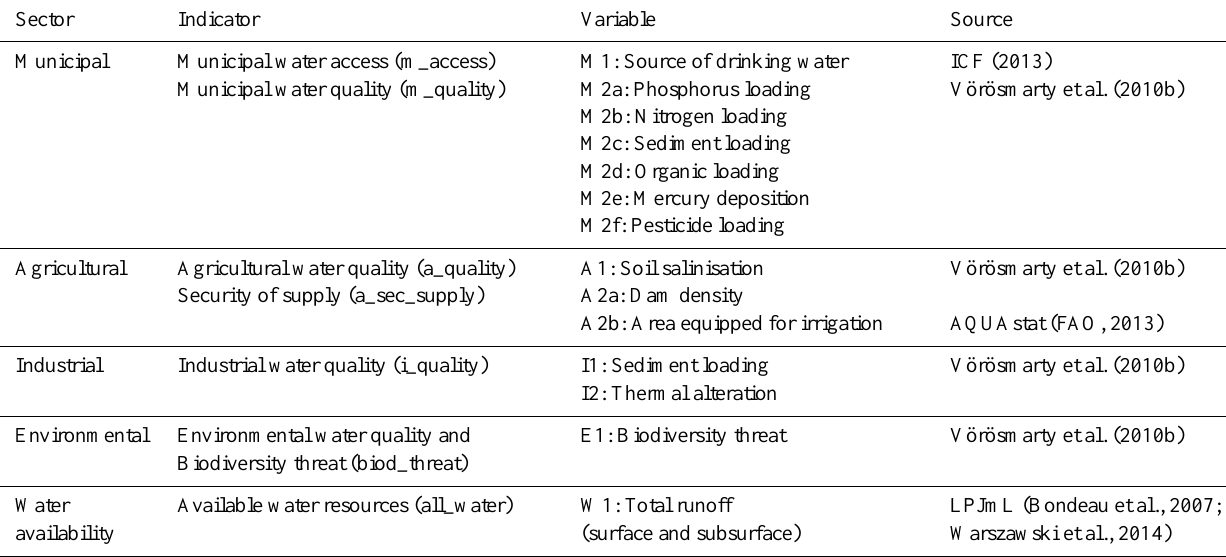
Table 2. Overview of data sources (variables) used to represent the indicators of water adequacy.